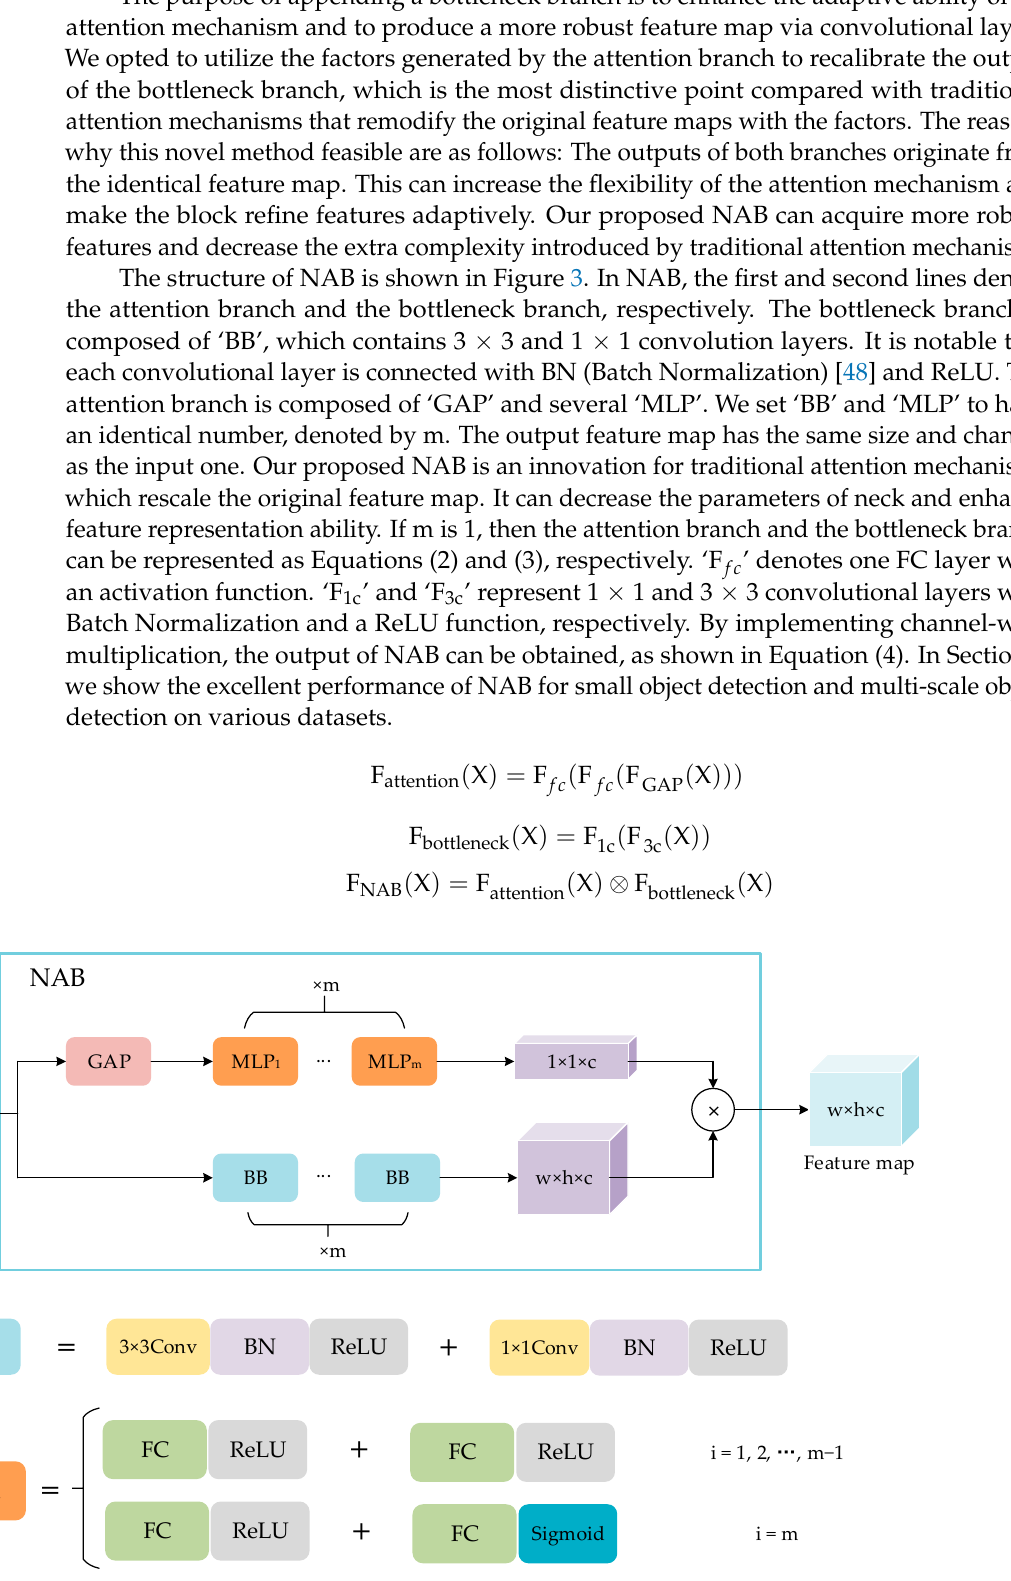
Figure 3. The structure of NAB. ‘BB’ is the abbreviation of bottleneck block. The number of ‘MLP’ and ‘BB’ denoted by m is equal. The second ‘FC’ in the last MLP uses a Sigmoid activation function to scale the factors into the range of 0–1.